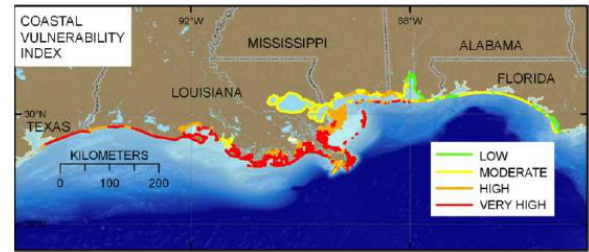
Figure 2. Northern Gulf of Mexico CVI calculated using Dolan et al . (1988) shoreline change data and sea-level rise rate from NOS/NOAA water-level gages (Pendleton et al ., 2010) In the Northern Ireland, McLaughlin and Cooper (2010)